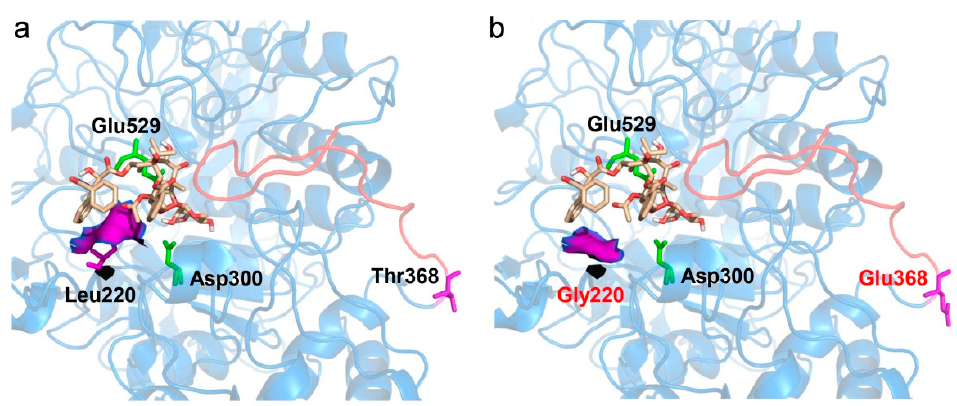
Figure 5. Partial view of molecular docking of LXYL-P1-2 ( a ) and EP2-L220G ( b ) with XDT. The carbon atoms of XDT are shown in wheat. The catalytic sites (Asp 300 and Glu 529 ) are shown in green. The amino acids in the position 220 and 368 are shown in magenta. The alteration of the loop near the active pocket by T368E mutation is shown in red.